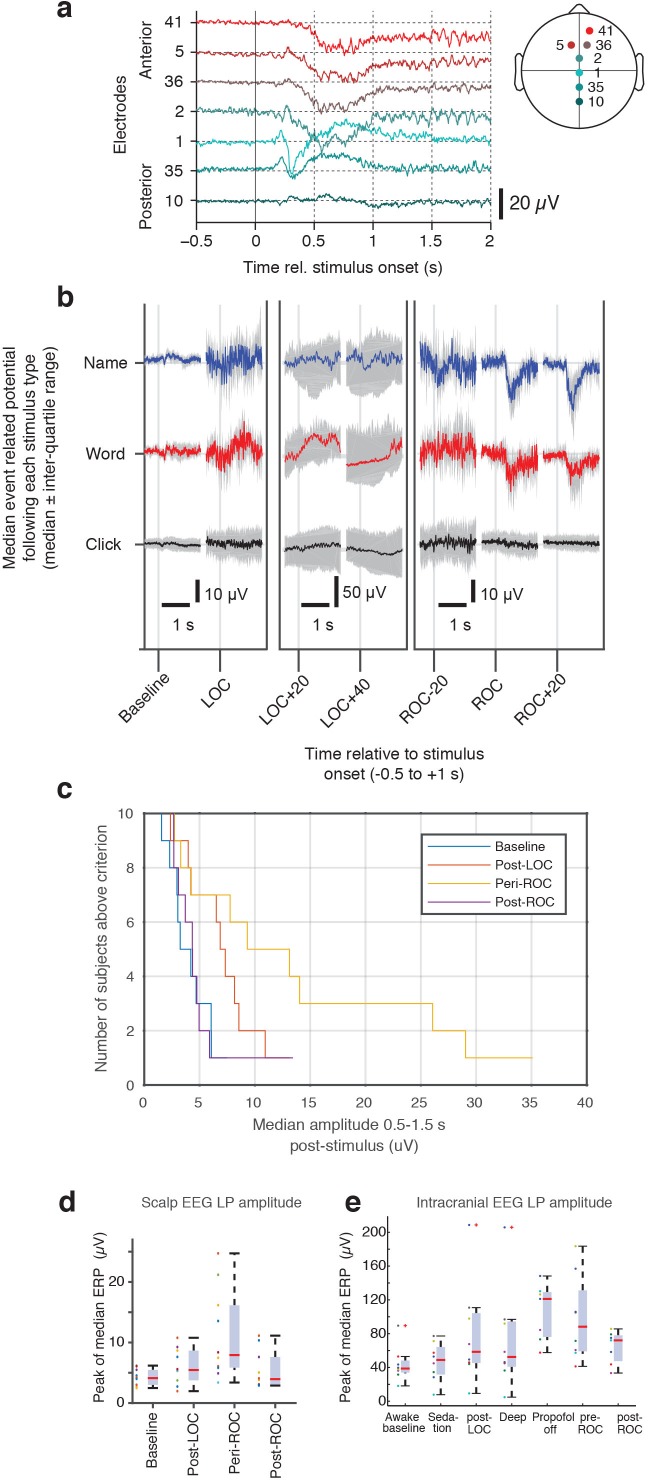
Evoked potentials in scalp EEG dataset.(A) Anterior-posterior spatial distribution of mean stimulus-evoked scalp LP during ROC. (B) Median stimulus-evoked potential in a representative subject who exhibited LPs: LPs are observed selectively during ROC in response to name and word stimuli, as seen by the median potential (red and blue, right panel). During LOC and anesthesia, variability is high and no mean evoked response is observed. (C) Distribution of number of subjects who exhibit LPs as the threshold for detection is varied. LPs are primarily observed around ROC, and lowering the threshold allows them to be detected in additional subjects (but with less selectivity for the high-LP state during the ROC epoch). (D) LP magnitude across all subjects in the scalp EEG dataset, calculated as the peak magnitude of the median ERP, shows increased LP appearance around the time of ROC. (E) The same peak calculation across all subjects in the intracranial EEG dataset also exhibits the largest LPs during emergence and around the time of ROC. One subject shows large peak values after LOC as well; this is due to insufficient trial numbers in this dataset for averaging away the effect of large spontaneous slow oscillations, biasing the peak computation.